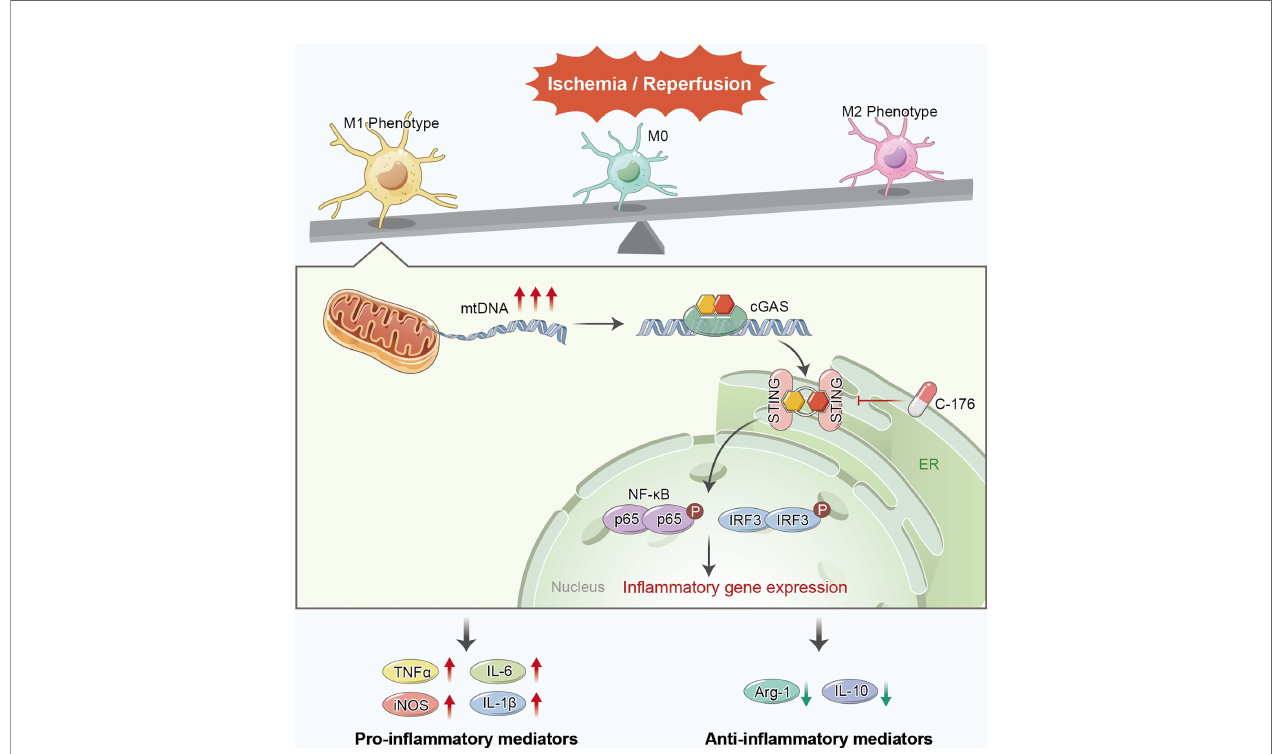
FIGURE 8 | Proposed mechanism of STING-mediated microglial polarization following ischemic stroke. I/R injury induces the leakage of mtDNA to cytoplasm and the activation of STING in microglia. Blockade of STING shifts the microglia toward M2 modality through IFR3 and NF- k B, thereby rescuing neuroin fl ammation and stroke outcomes. mtDNA can promote microglial polarization to the M1 phenotype via activating STING signaling